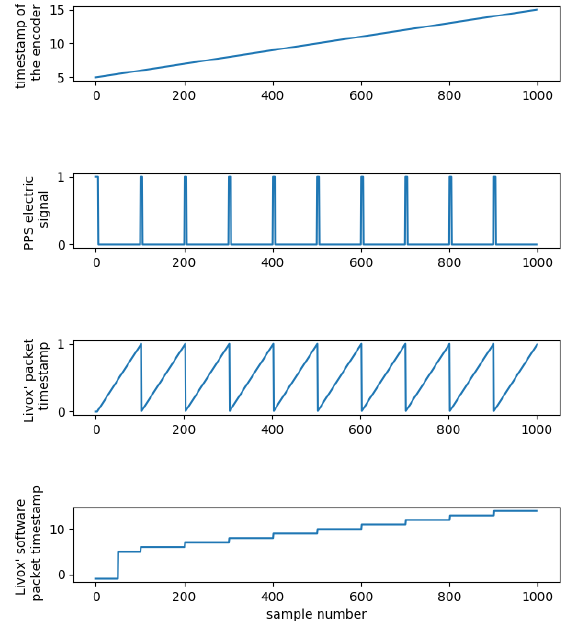
Figure 7. Time diagram of synchronization signals, register, and timers.